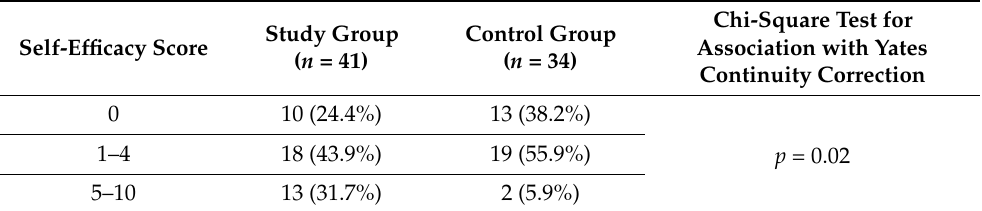
Table 17. Distribution of Parent’s self-efficacy scale scoring on using devices during family mealtimes question